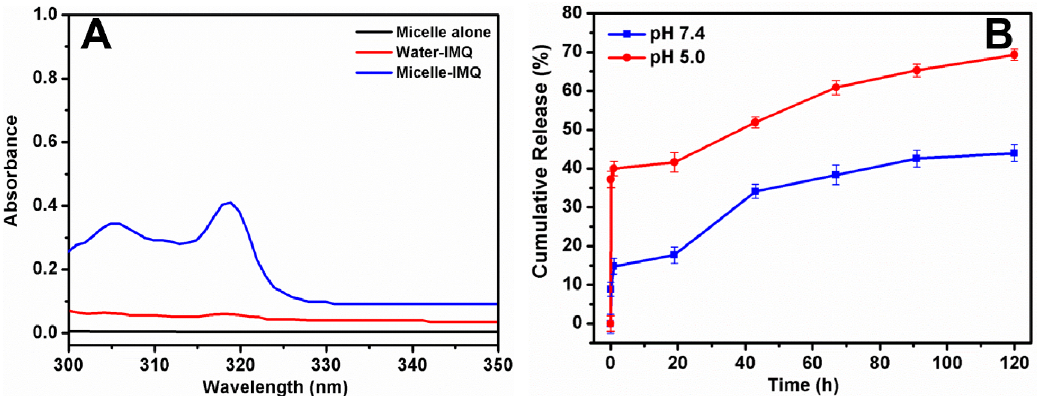
Figure 6. Enhancement of solubility and accelerated release of IMQ through encapsulation in β -CD-(PLA- b -PDMAEMA- b -PEtOxMA) 21 unimolecular micelles. ( A ) UV spectra of the IMQ-loaded micelles solution, water-IMQ solution, and blank micelle solution, pH 7.4; ( B ) In vitro release profiles of IMQ from micelles at pH 7.4 and 5.0.